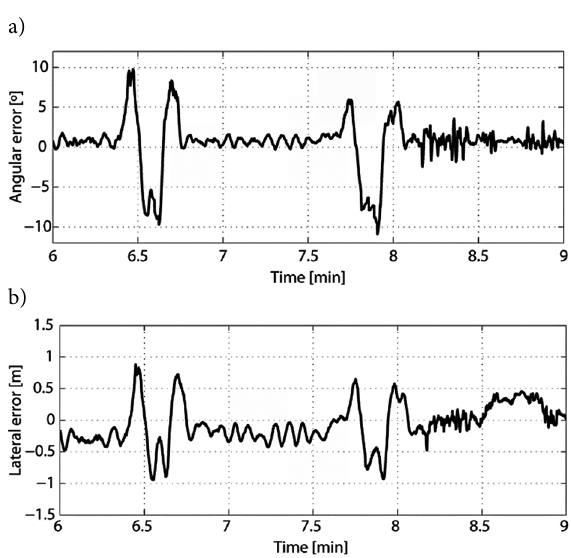
Fig. 17. Speed of the two vehicles on the motorway